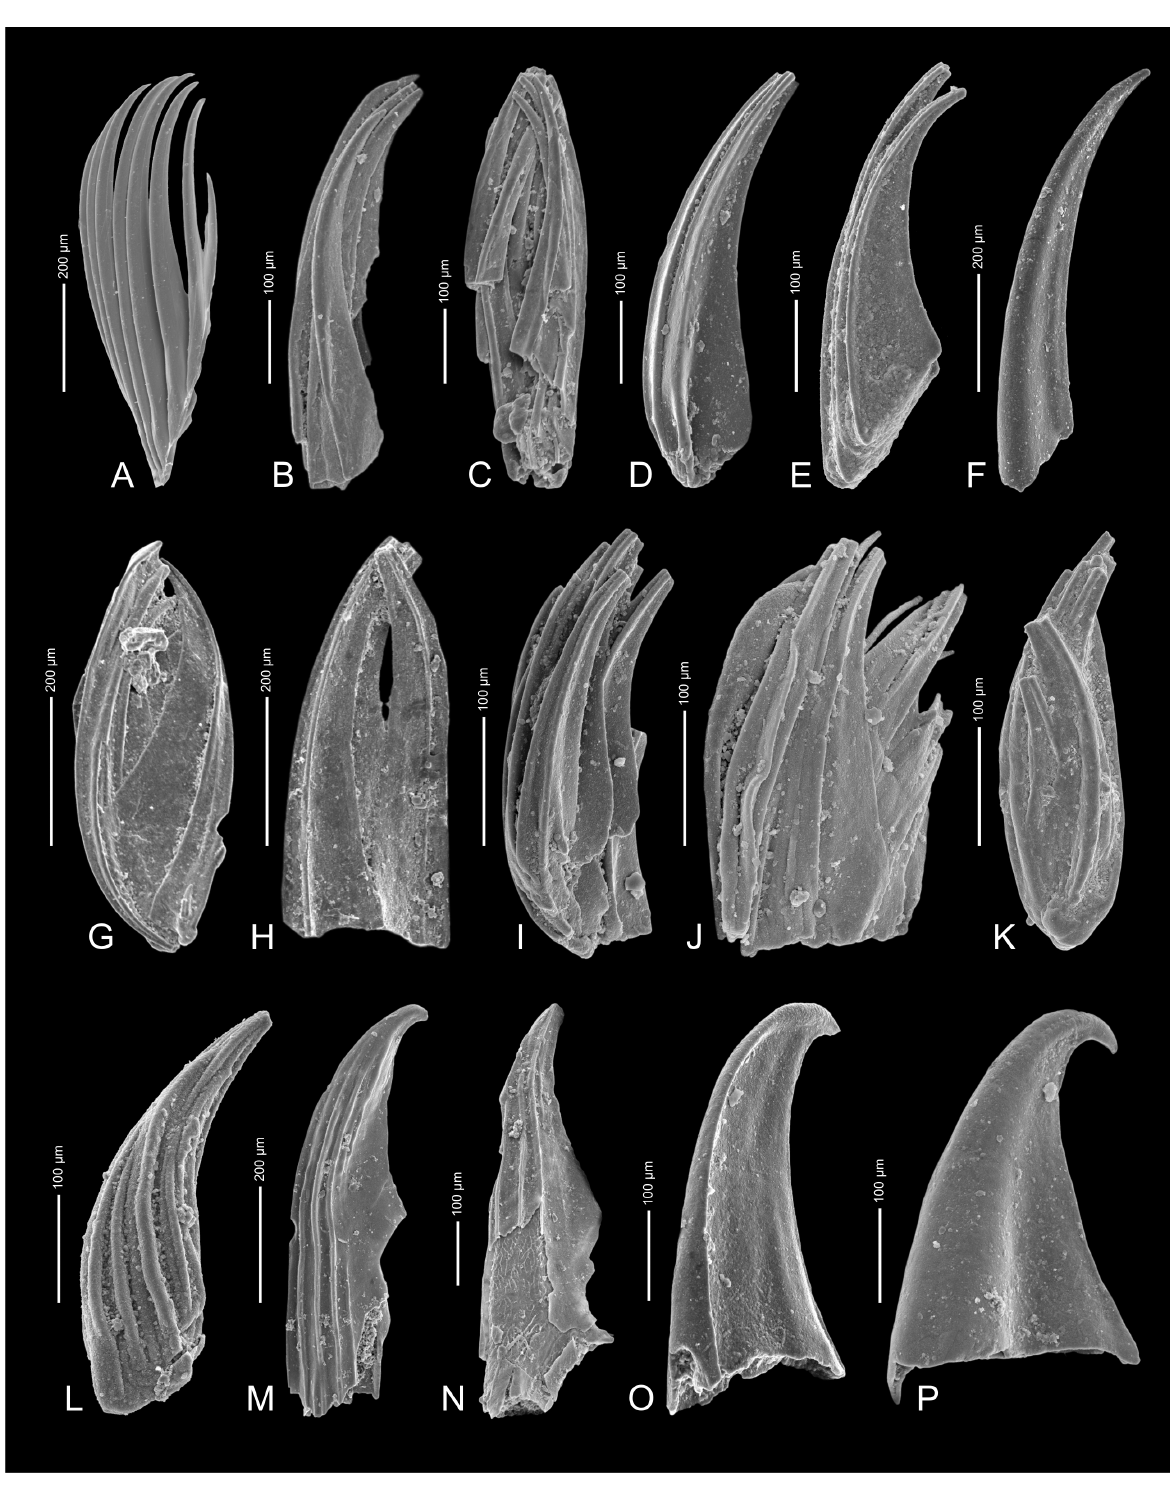
Fig. 1. A , recent Sagitta sp., grasping half apparatus in dorsal view; ZPAL CIV/1.1. B, C , Phakelodus sp., incomplete half apparatus in dorsal view, Tremadocian, Sweden, ˜leklinta; ZPAL C23/1. D(cid:150)P , elements and incomplete apparatuses of coelocerodonts (new term), Tremadocian, Sweden, ˜leklinta; ZPAL